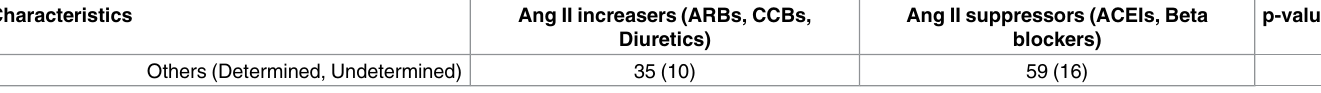
(Table 3), the effects of Ang II increasers compared to Ang II suppressors on ischemic stroke